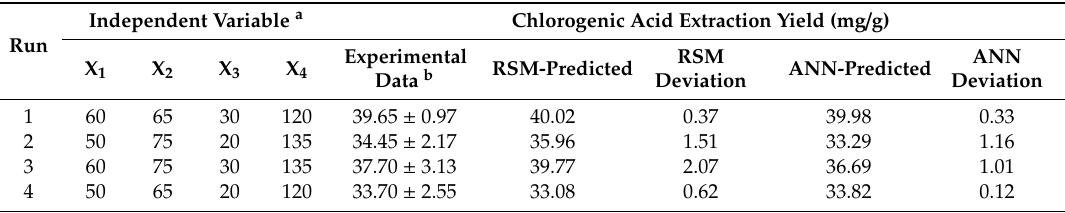
Table 4. Validation experiments for the ultrasound-assisted extraction of CGA.